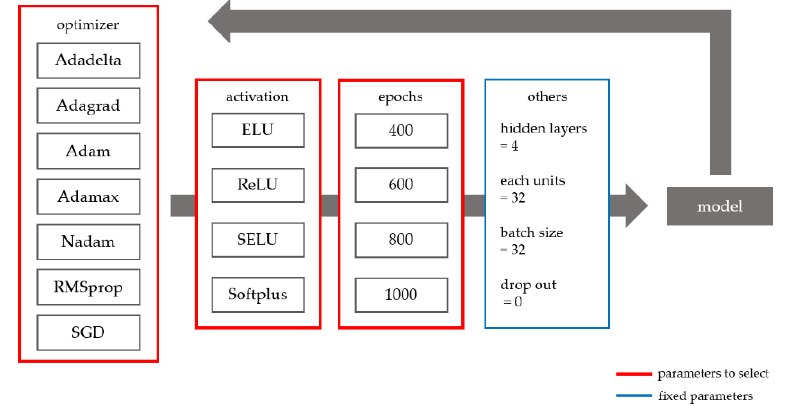
Figure 5. Deep learning parameter selection.